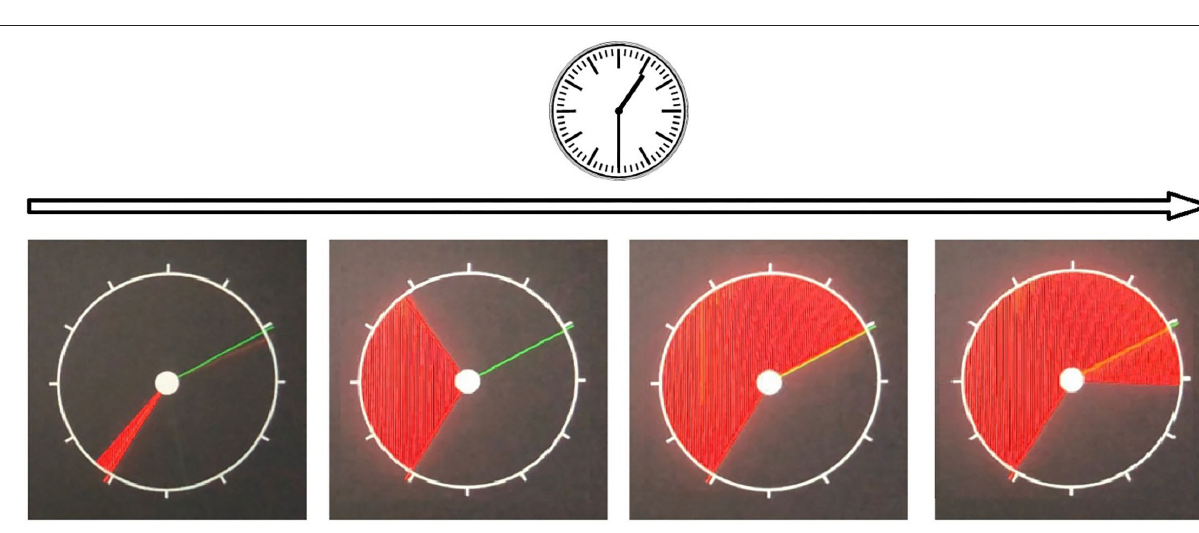
FIGURE 2 | Reaction to a moving object